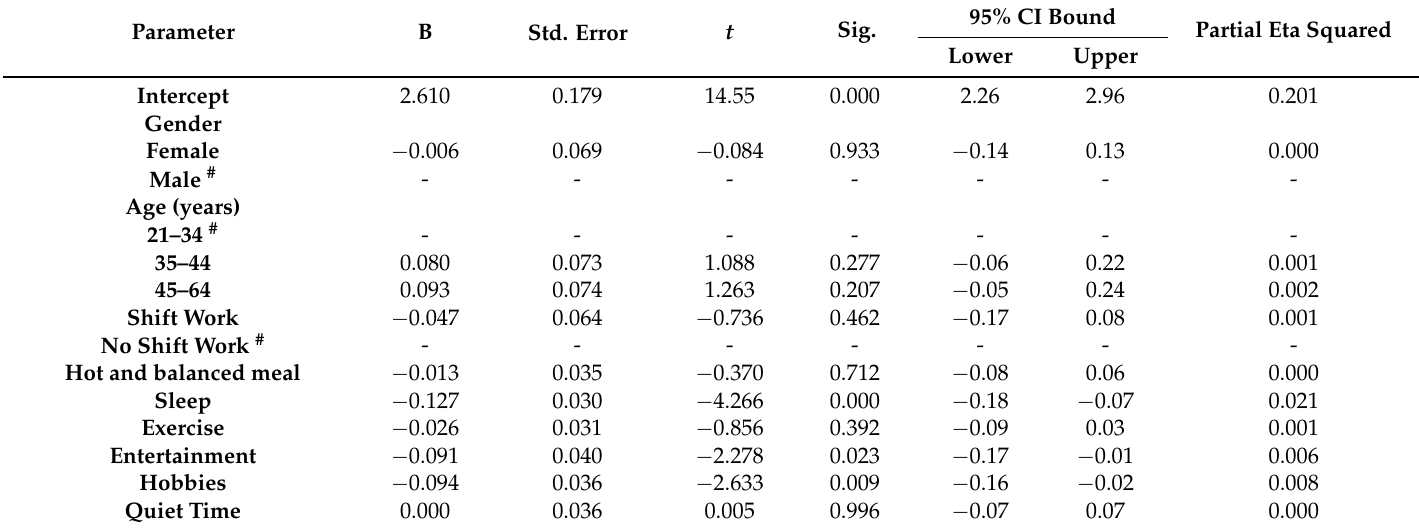
Table 5. Generalized linear model, parameter estimates, dependent variable: DASS depression